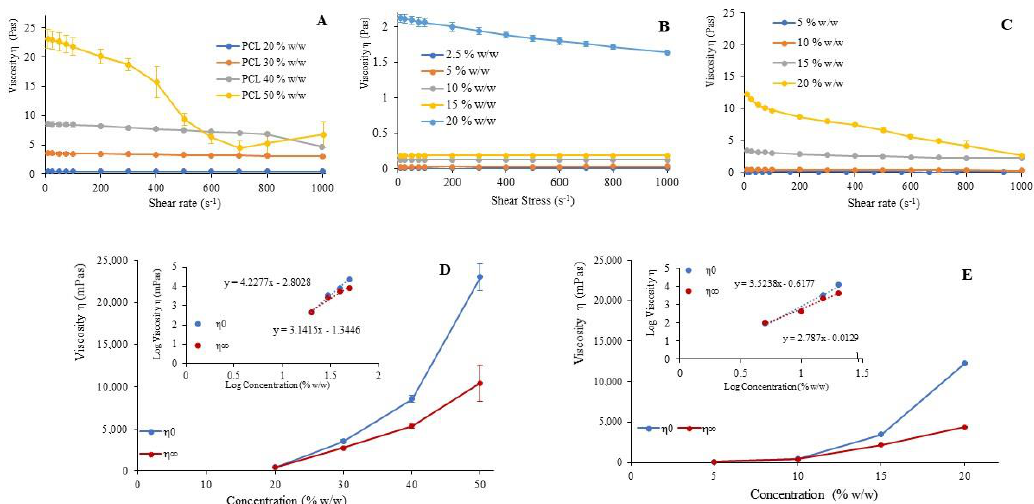
Figure 1. Rheological characterization of the polymer solutions. Viscosity (Pa.s) vs shear rate (s − 1 ) profiles of polymeric solutions prepared at di ff erent concentrations (% w / w) in 90% v / v acetic acid for poly- ε -caprolactone (PCL) ( A ), collagen ( B ) and collagen / PCL 1:1 ( C ) (mean values ± s.d.; n = 3). Average values of η0 and η∞ against concentration (a) and bi-logarithmic transformation of the same profiles (in the insert, b) evaluated for the solutions in 90% v/v acetic acid for PCL ( D ) and collagen/PCL 1:1 ( E ) (mean values ± s.d.; n = 3).